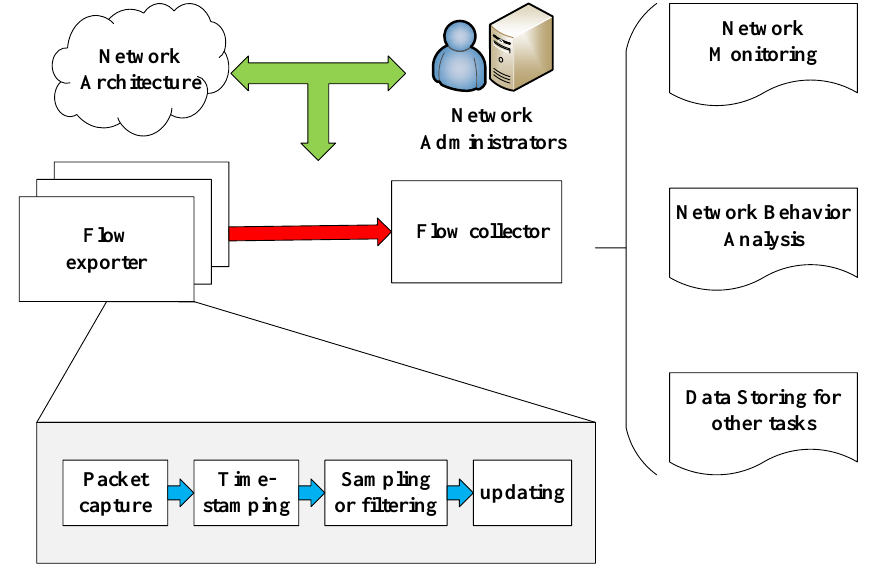
Figure 2. The architecture of network flow exporting and collecting procedure.